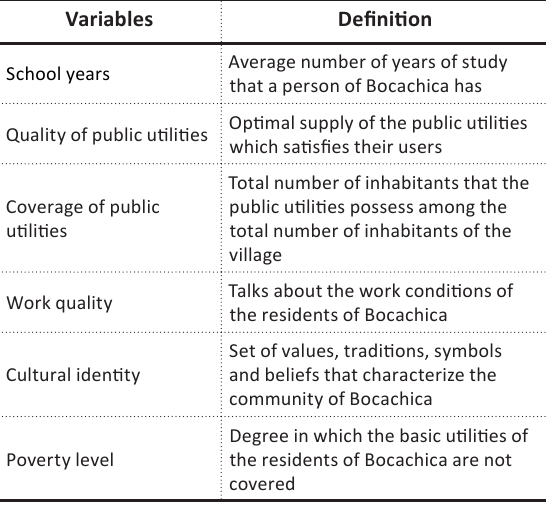
Source: Elaborated by the authors.